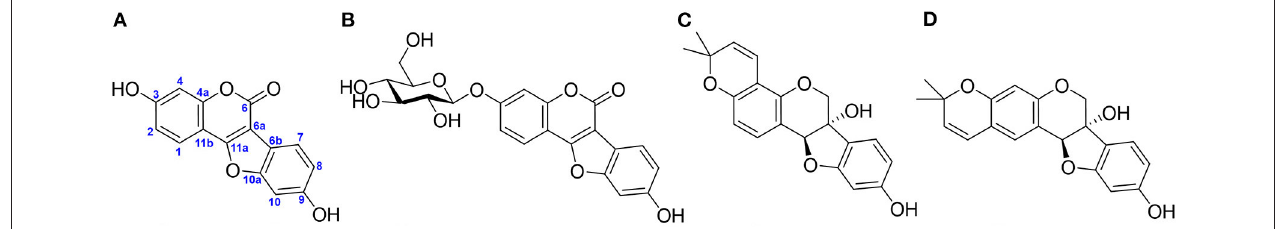
FIGURE 1 | Representative phytoalexins in soybean reported in the literature. (A) Coumestrol (CMS), (B) CMS 3- O -glucoside, (C) glyceollin I, and (D) glyceollin II.